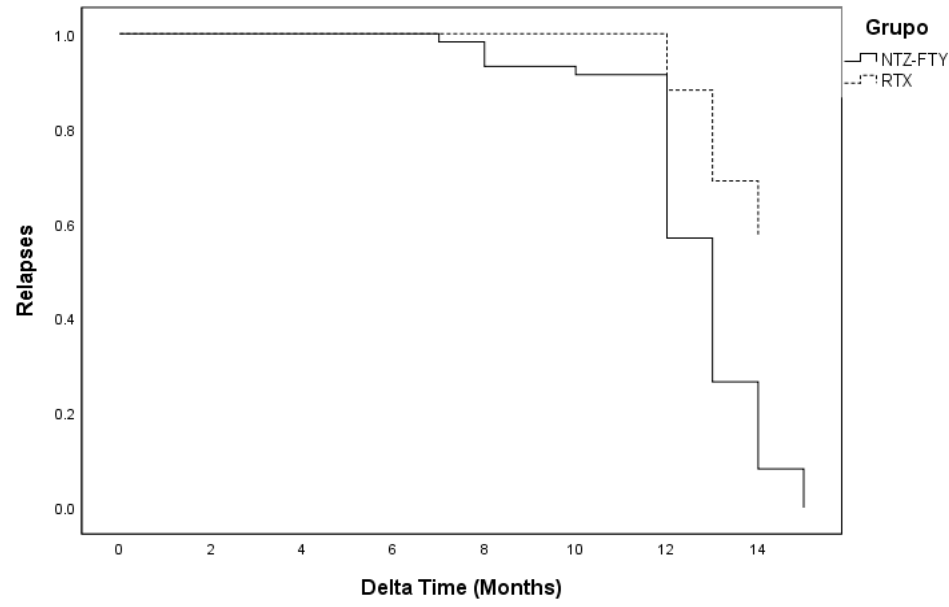
Figure 2. Cox regression model for relapses with Δ Time.